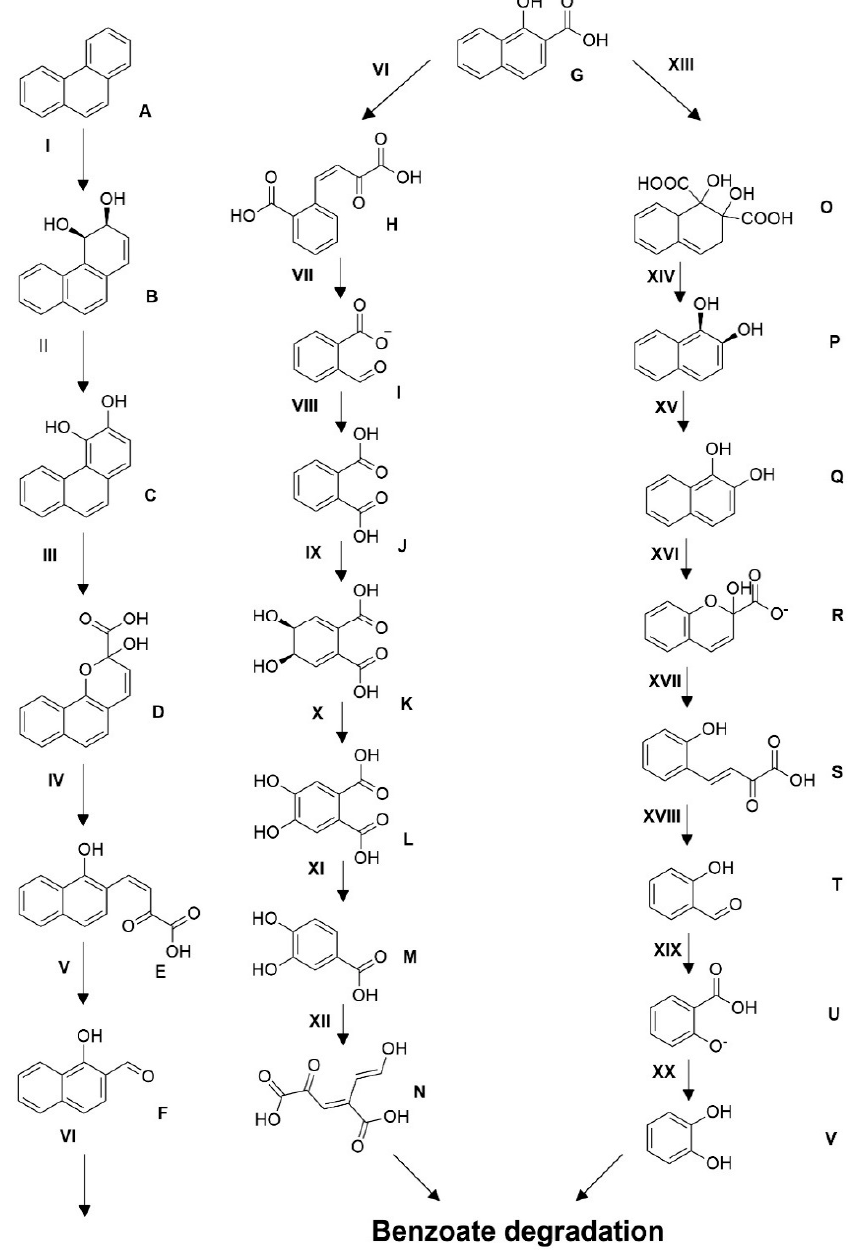
Figure 9. Proposed pathway for phenanthrene degradation by D. psychralcaliphila JI1D. The legend for the figure is provided in Supplementary Table S7.